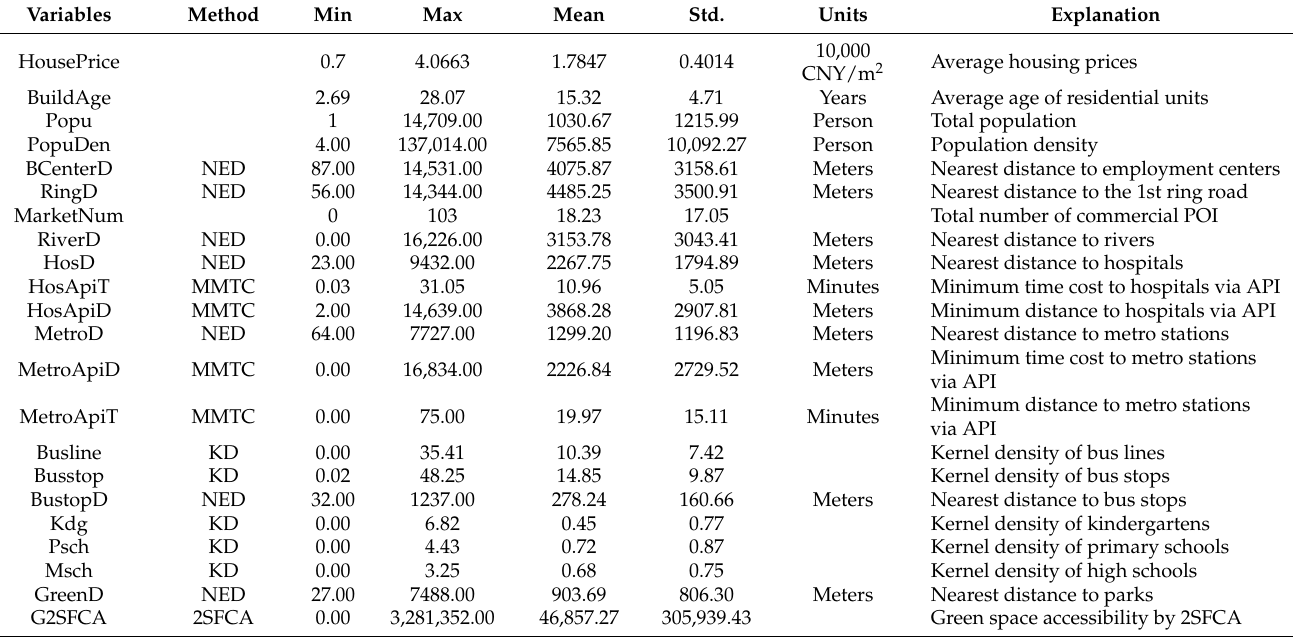
Table 1. Statistical description of variables.